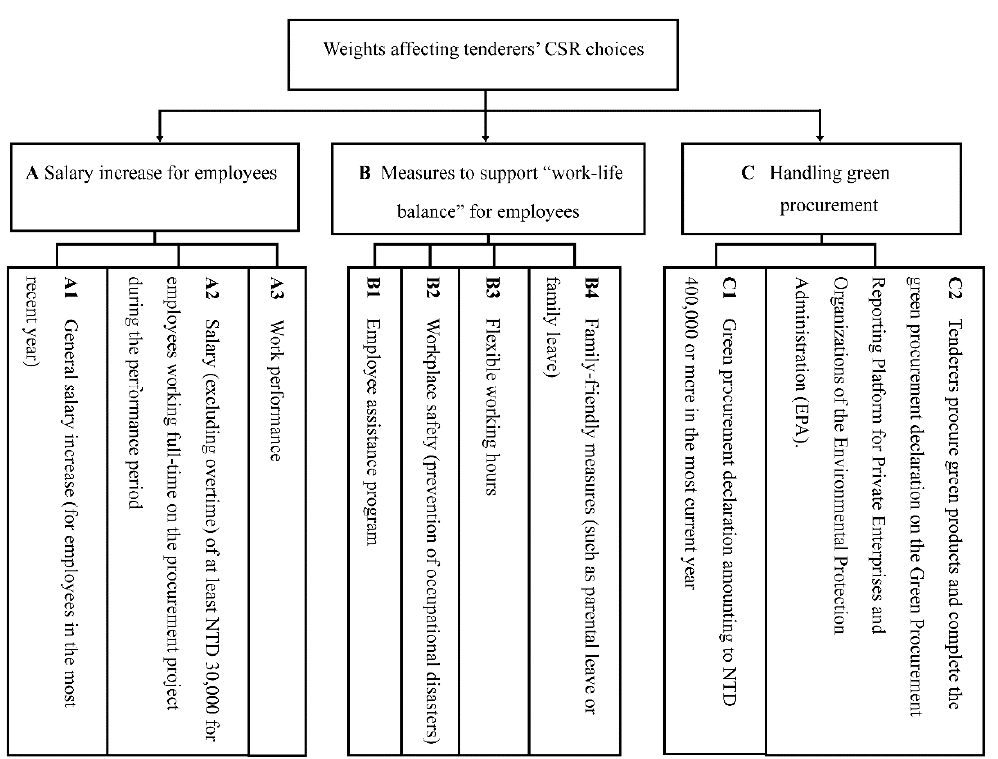
Figure 2. Research Framework of Weights Influencing Tenderers’ CSR Choices.